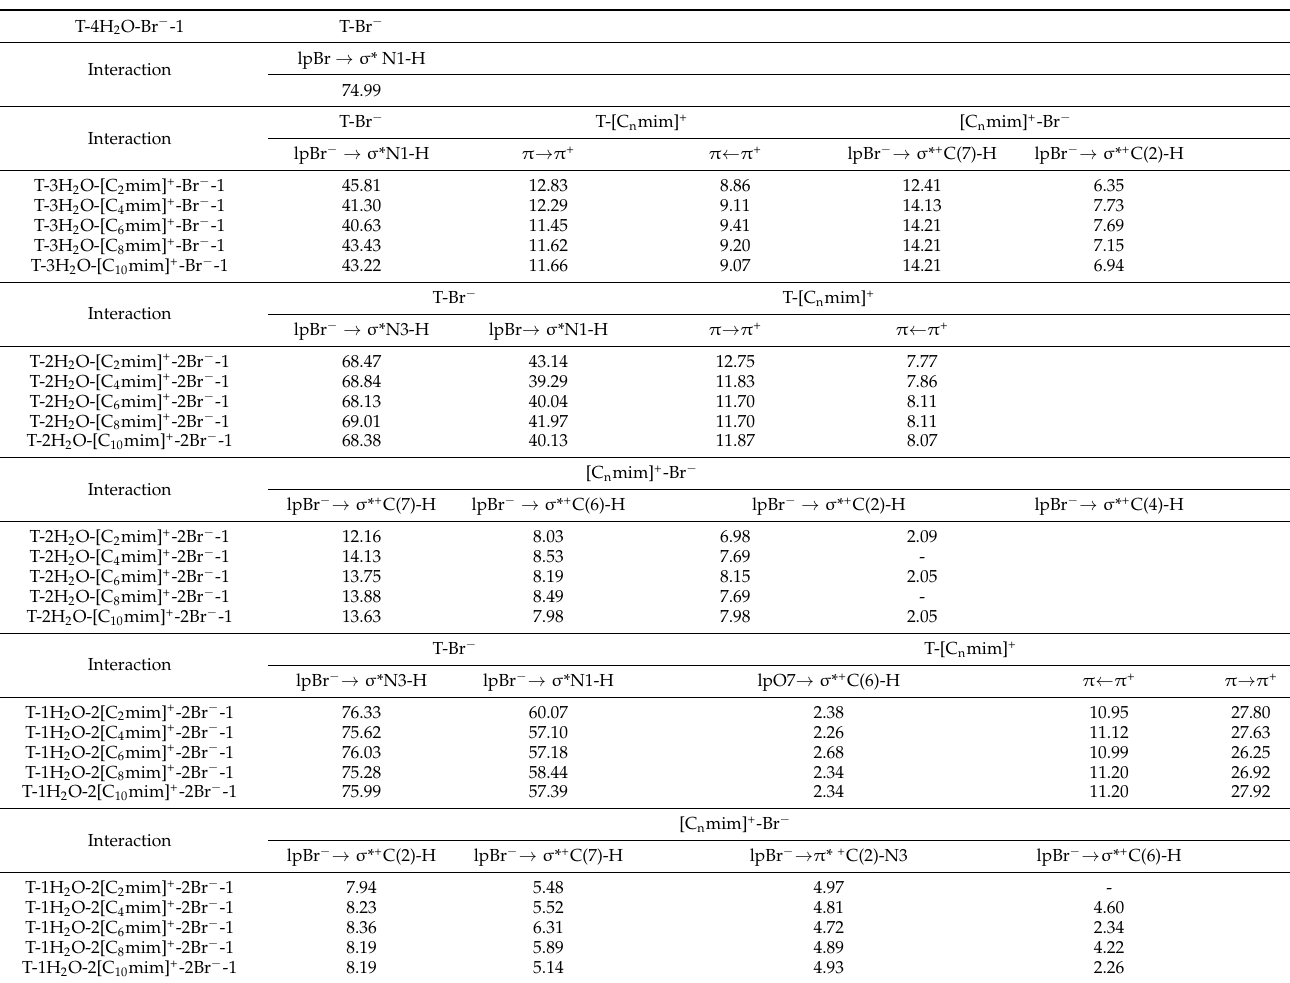
Table 3. The donor-acceptor interaction energies ( E 2 , kJ/mol) obtained from the NBO analysis on the wave functions for the microhydrates, T-4H 2 O-Br − -1, T-3H 2 O-[C n mim] + -Br − -1, T-2H 2 O-[C n mim] + - 2Br − -1, and T-1H 2 O-2[C n mim] + -2Br − -1 ( n = 2, 4, 6, 8,